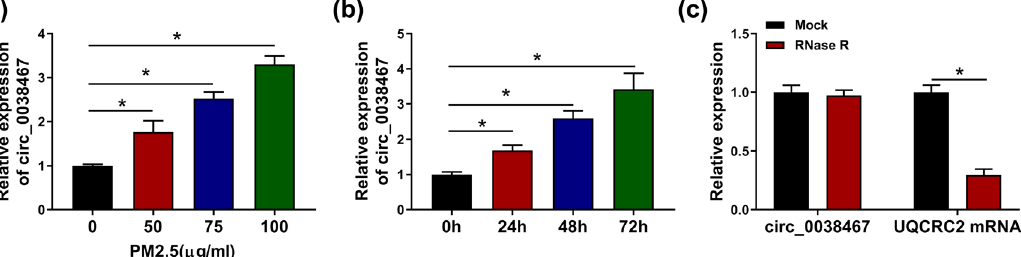
Figure 1: PM2.5 accelerated circ_0038467 expression in BEAS - 2B cells. ( a and b ) RT - qPCR analysis of circ_0038467 expression in BEAS - 2B cells exposed to a range of concentrations of PM2.5 ( 0, 50, 75, and 100 µg/mL ) over di ff erent time - periods ( 0, 24, 48 and 72 h ) . ( c ) RT - qPCR analysis of the expression of circ_0038467 and linear transcript UQCRC2 after RNase R treatment. N = 3, * P